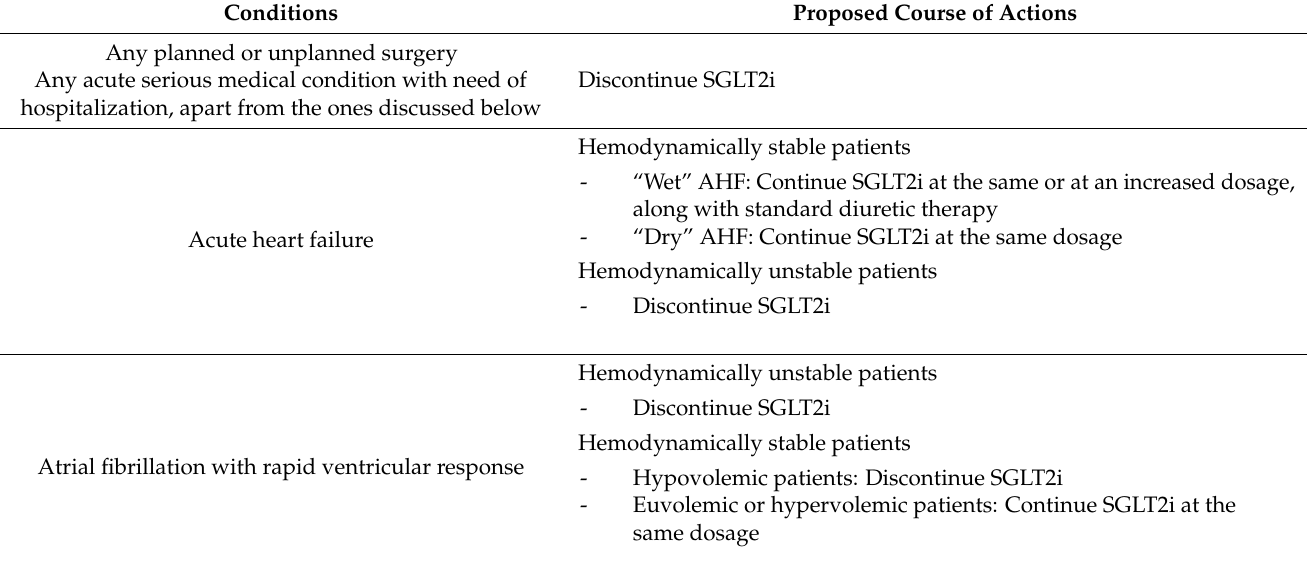
Table 3. Proposed management of patients taking SGLT2is at baseline in the case of acute heart failure, atrial fibrillation with rapid ventricular response, acute diabetes decompensation, and gout